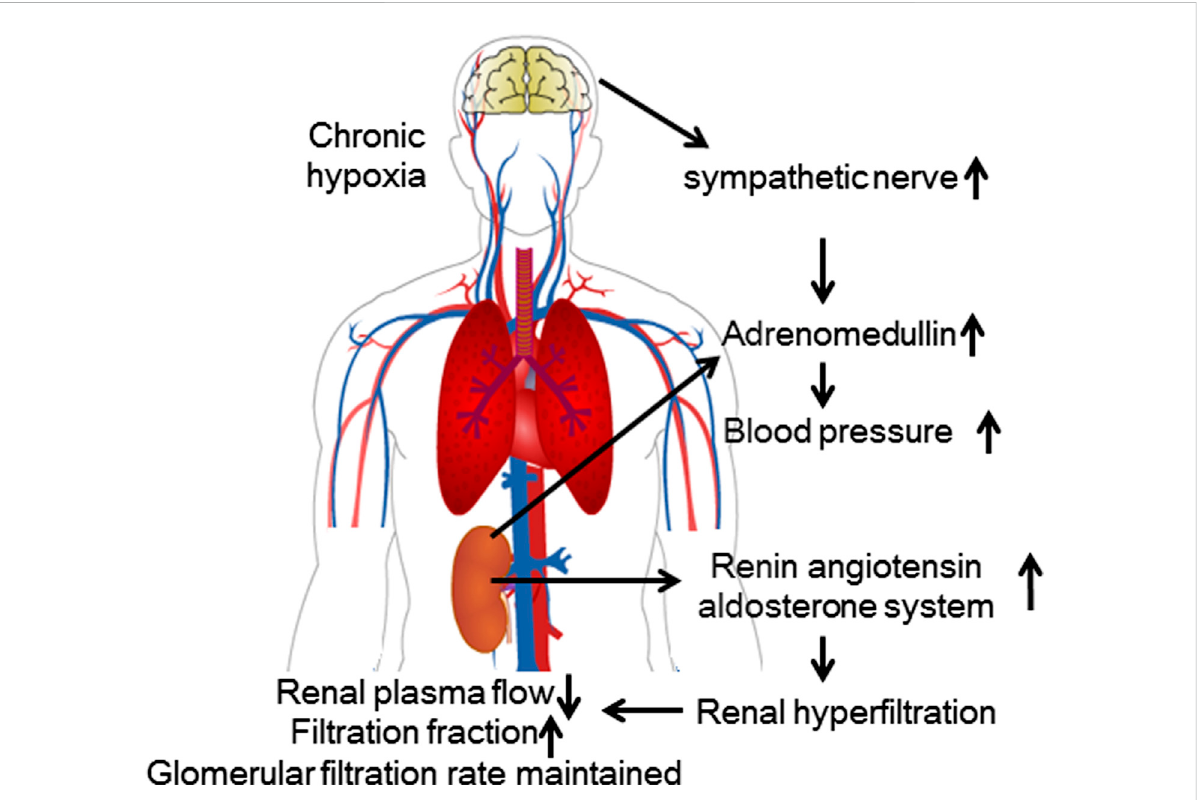
FIGURE 2 Renal physiological response to chronic high-altitude exposure. During chronic exposure to hypoxic conditions, the increased activity of the RAAS causes glomerular hyper fi ltration. Although renal blood fl ow decreases, the GFR remains relatively